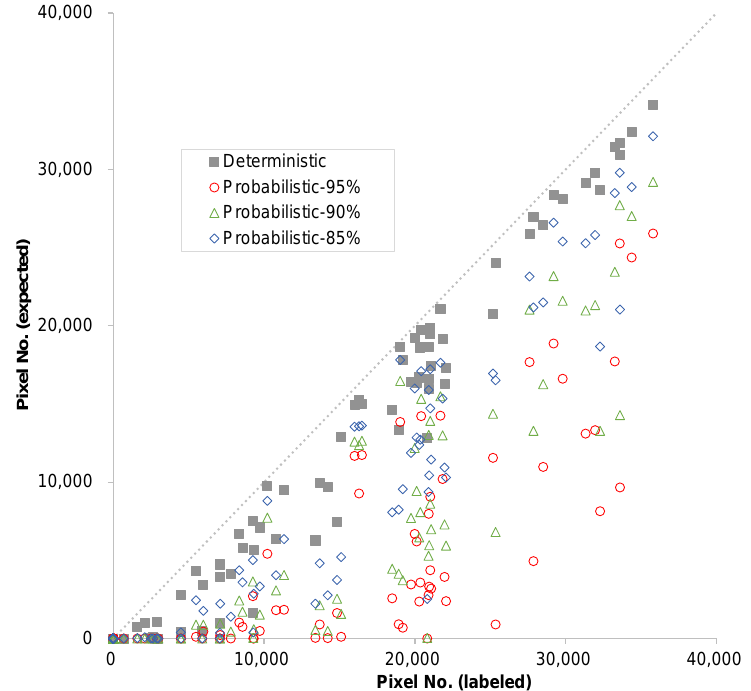
Figure 7. Labeled vs. expected pixel numbers of concrete area in images for testing set.